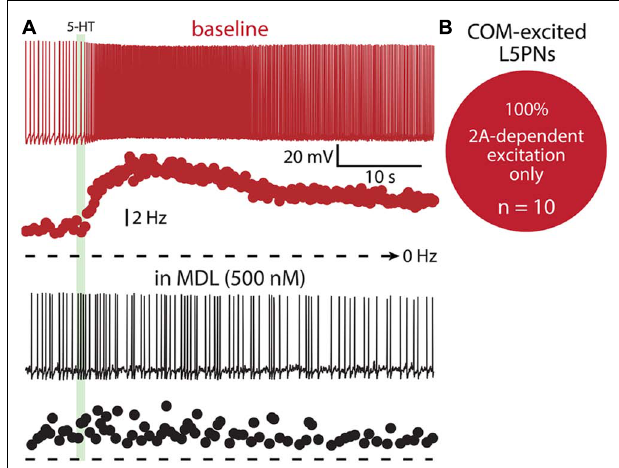
FIGURE 10 | COM-excited L5PNs do not exhibit 1A-mediated inhibition after blockade of 2A receptors. (A) Voltage responses (top traces) and plots of ISF (lower plots) for a COM-excited L5PN exposed to 5-HT (green bar) in baseline conditions (red) and after application of the 2A receptor antagonist MDL 11939 (MDL; black). (B) Proportion of COM-excited L5PNs showing non-inhibitory responses to 5-HT in the presence of